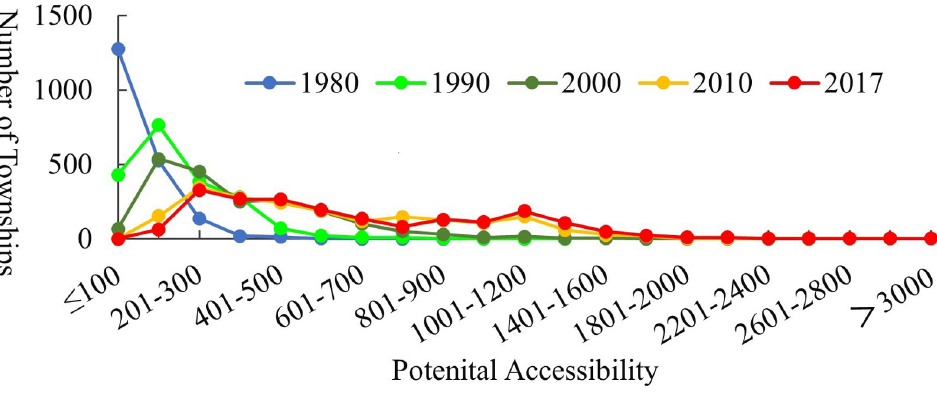
Fig 4. Potential accessibility distribution and